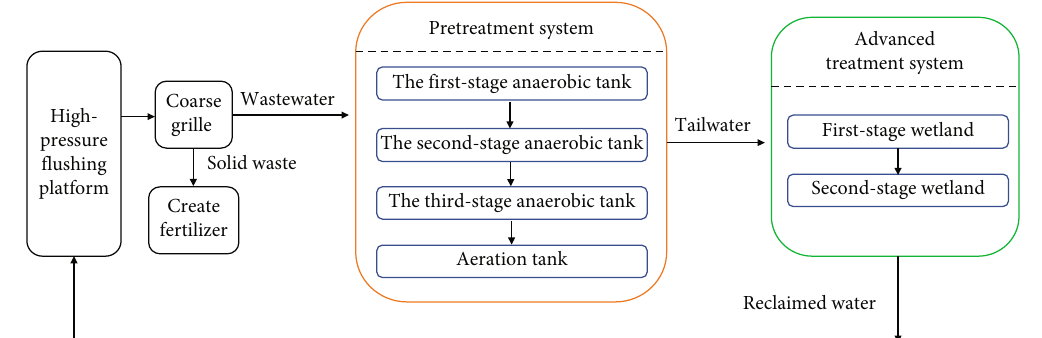
Figure 2: Technical fl ow chart of the phase I project.